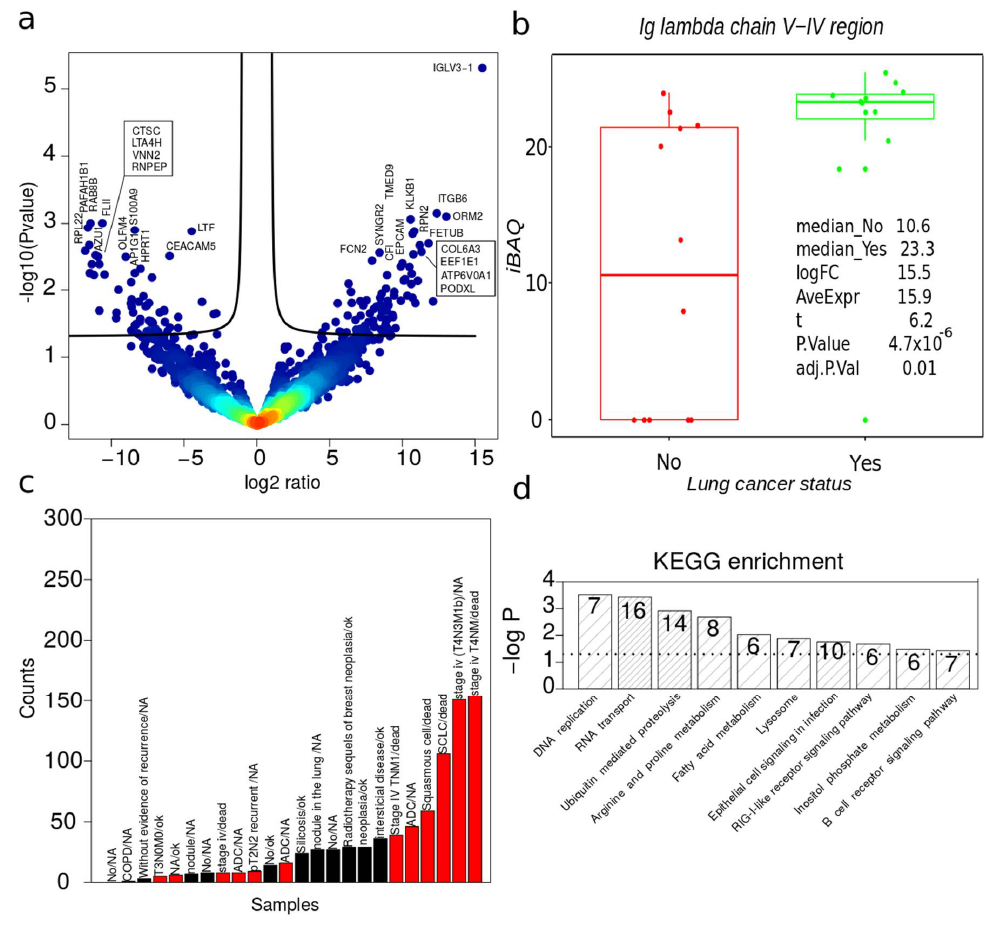
Figure 4. Dysregulated lung cancer proteins in BAL EVs: ( a ) Volcano plot summarizing the main dysregulated proteins where –log10 p values were corrected for gender and smoking; ( b ) top regulated protein after correction for multiple testing; ( c ) number of unique proteins per sample (red bars indicate lung cancer and black bars represent controls); ( d ) KEGG functional enrichment of cancer unique proteins. The numbers in the bars represent the number of cancer unique proteins in the functional category. The dashed line indicates the p -value threshold ( <